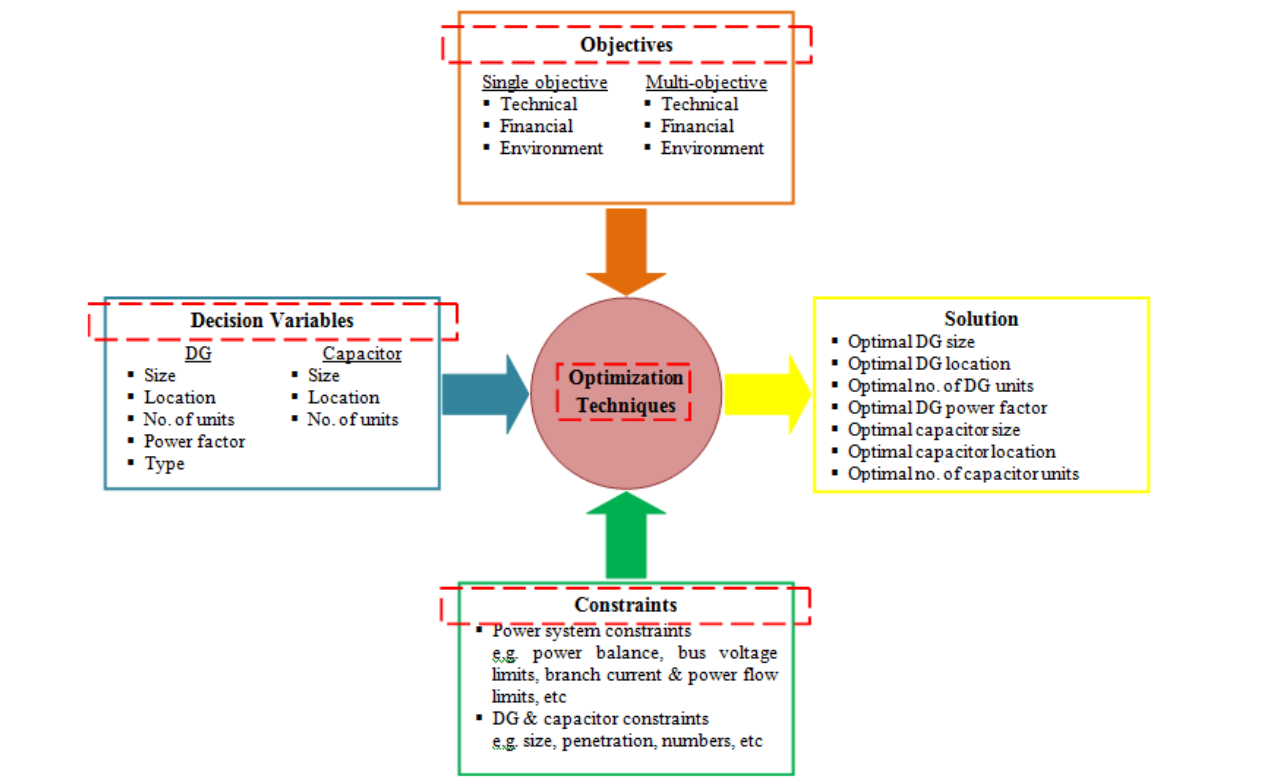
Figure 7. Components of the DG and SCB planning framework.